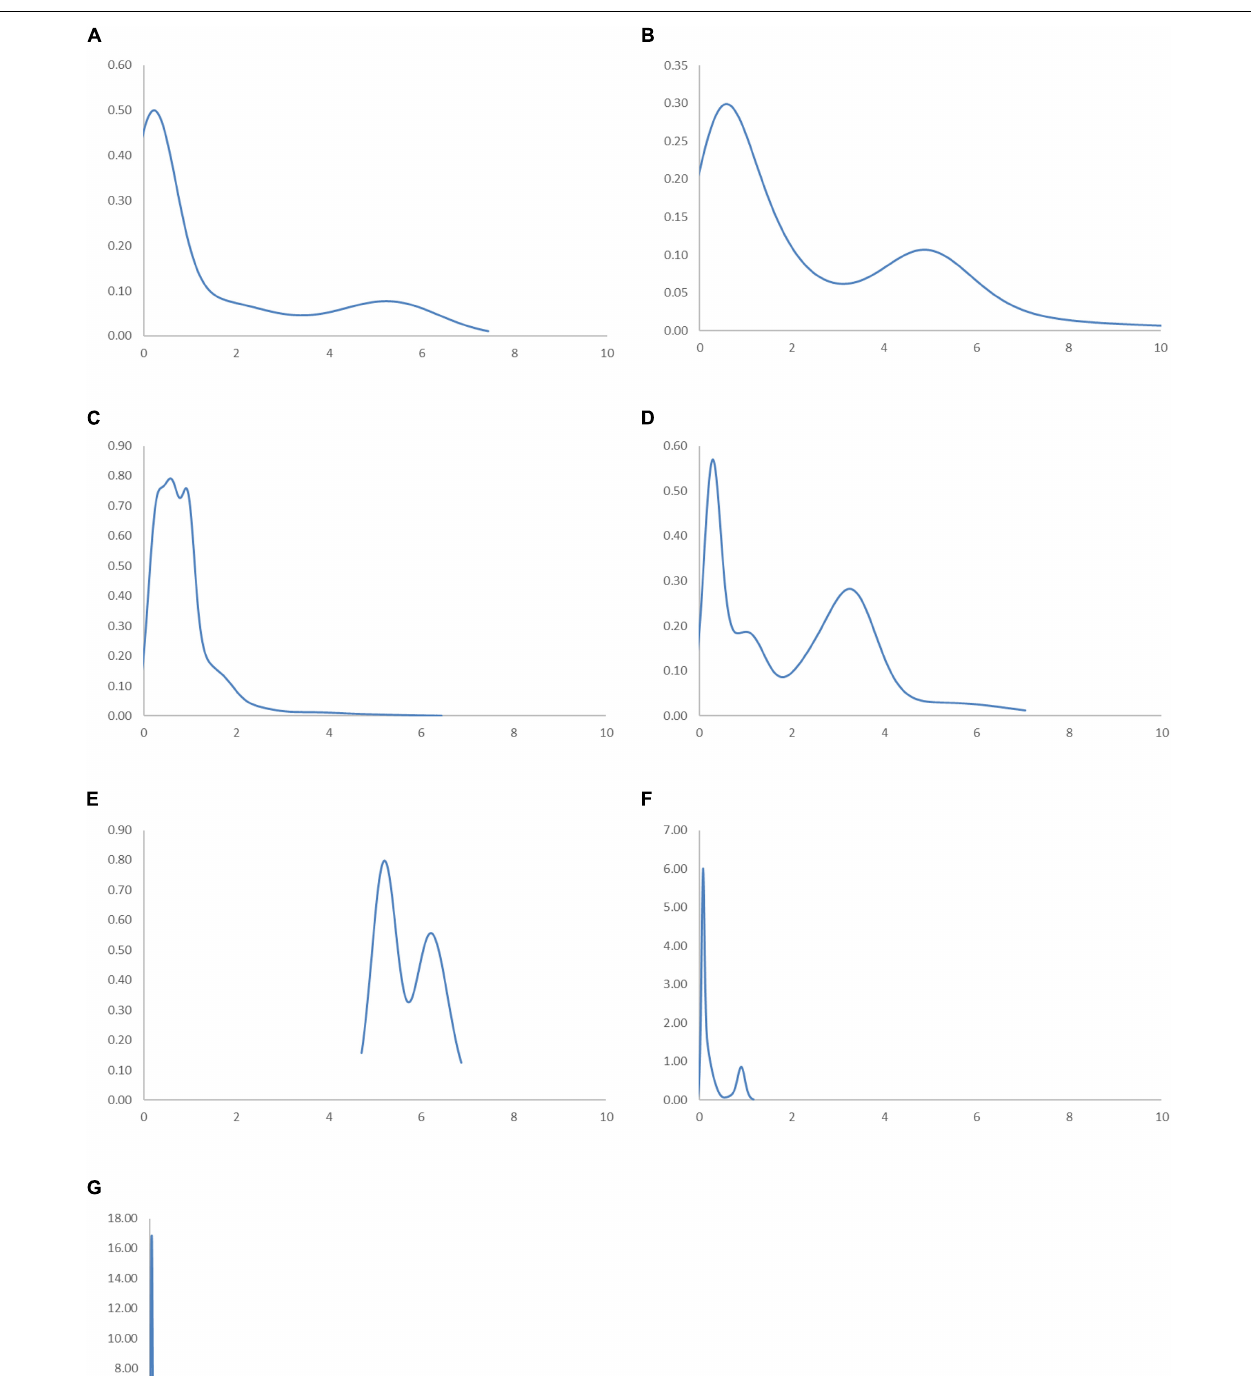
FIGURE 13 | Ergodic distributions for the RSVAPC of countries for different geographical regions with annual transitions. Source: Authors’ calculation. N.B. The vertical axis indicates the density of probability and the horizontal axis indicates RSVAPC values. (A) East Asia and Pacific; (B) Europe and Central Asia; (C) Latin America and the Caribbean; (D) The Middle East and North Africa; (E) North America; (F) South Asia; (G) Sub-Saharan Africa.